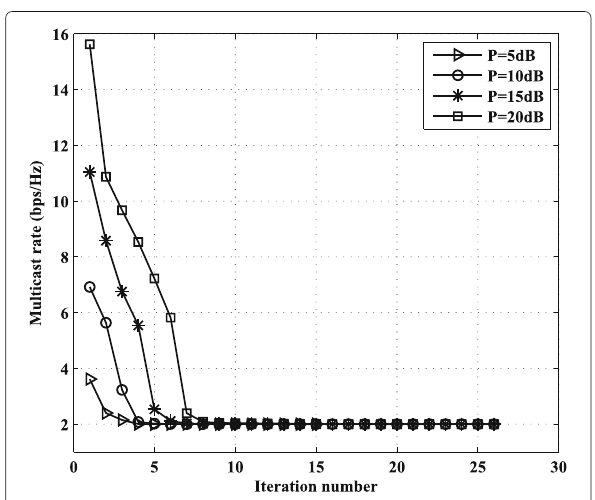
Fig. 1 DC algorithm: convergence of the multicast rate